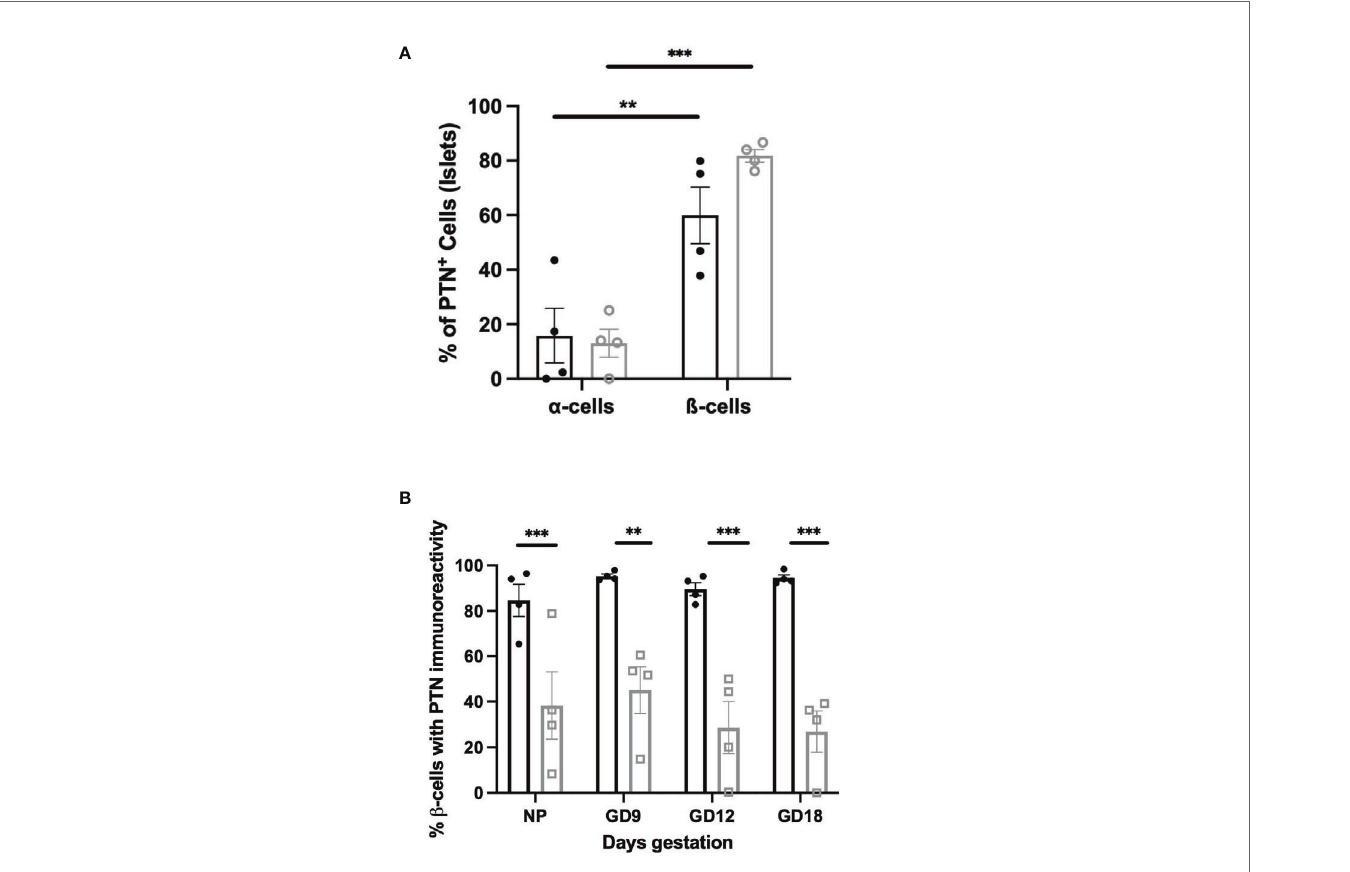
FIGURE 4 | (A) Co-localization of PTN with a - or b -cells based on glucagon or insulin immunoreactivity respectively within sections of the female mouse pancreas. Results are shown as % of total a - or b -cells per islet that are PTN-positive in non-pregnant (black) or GD 12 (grey) mouse pancreas. **p < 0.01, ***p < 0.001 vs. a -